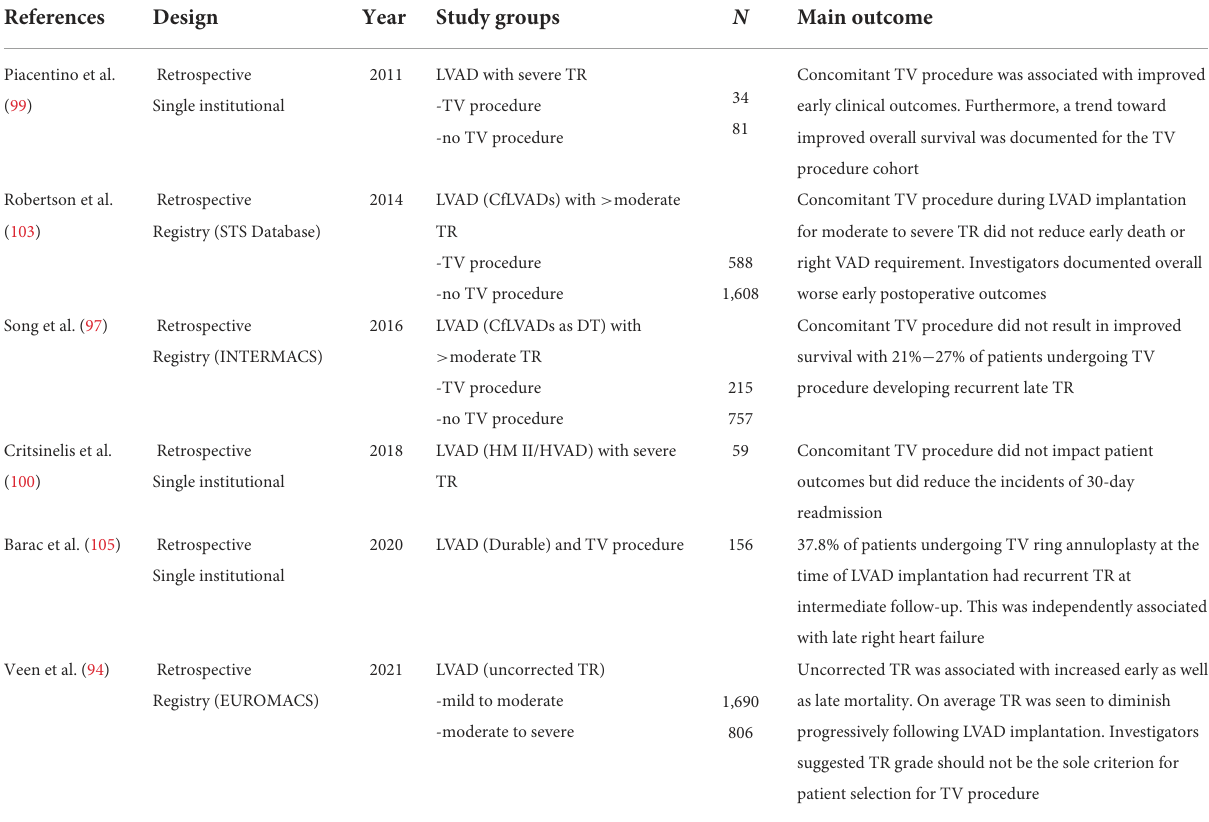
TABLE 3 Key studies in chronological order of publication reporting on the interaction of TR and LVAD